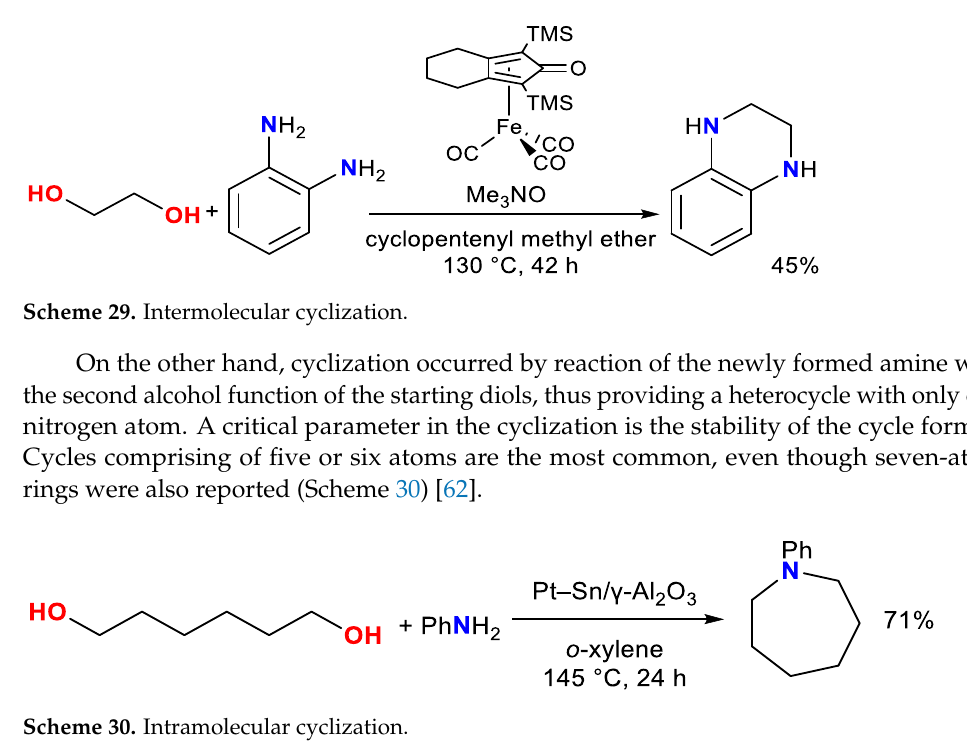
Table 5. Typical catalysts used for diol